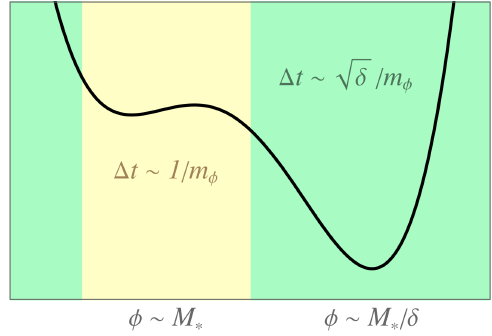
Figure 9 . Schematic view of the structure of the potential including the time to cross the local (global) region around (far from) the metastable minimum. Scalars that roll to the deep minimum and lead to a crunching universe take most of the time to cross the local region (